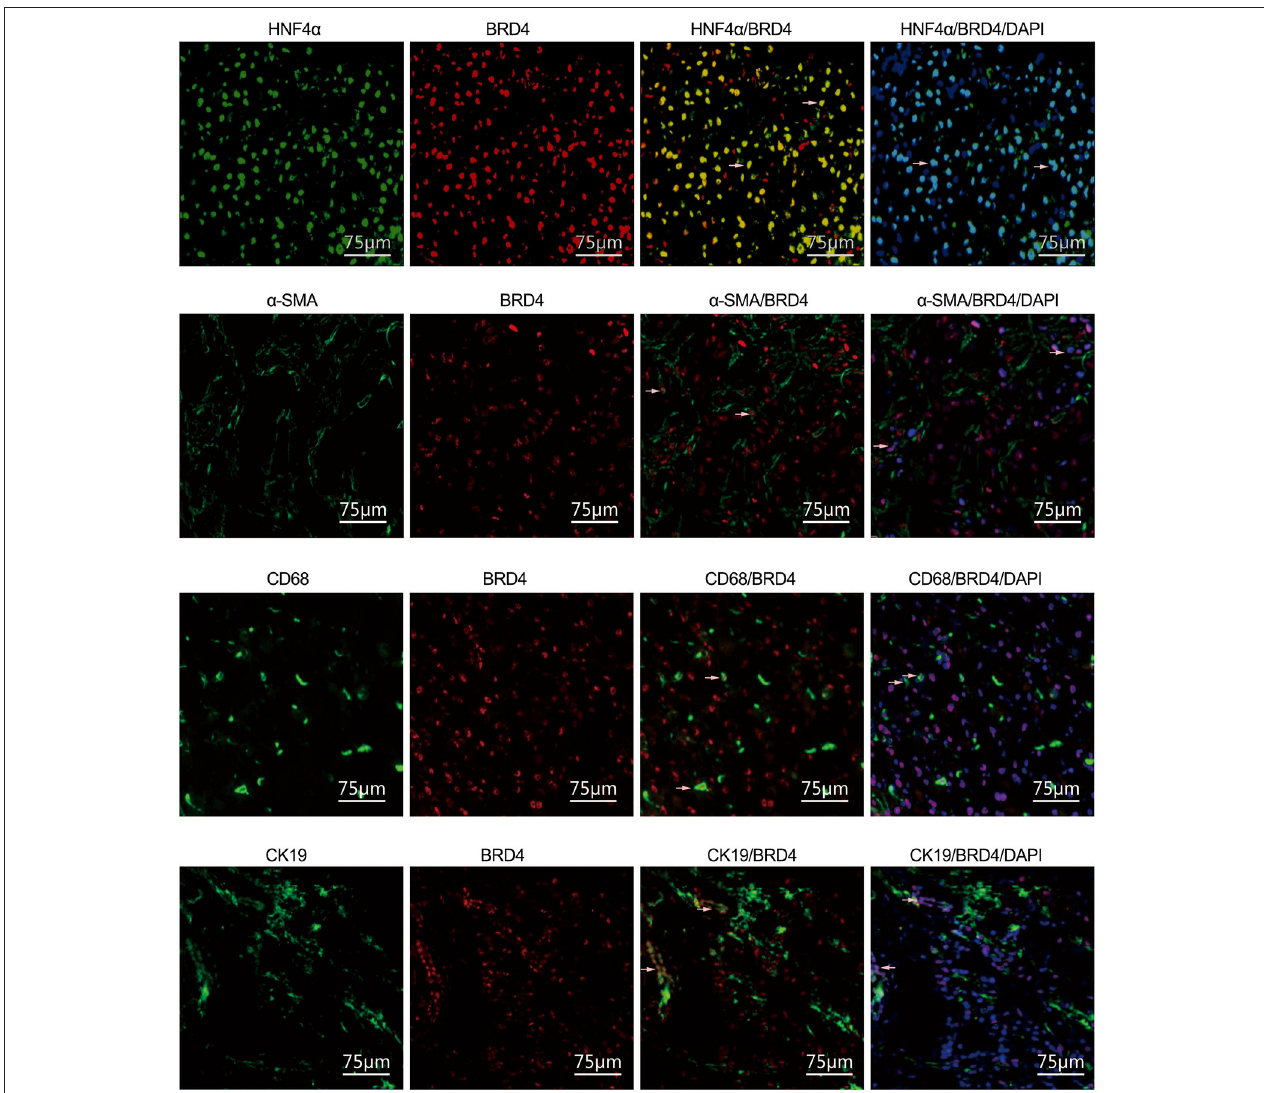
FIGURE 3 | Immunofluorescence analysis of cellular localization of BRD4 in the liver tissues. Immunofluorescence (IF) analysis was conducted to visualize the cellular localization of BRD4 in the liver tissues as described in Materials and Methods. The representative double immunofluorescence images showed expression of HNF4 α (green), α -SMA (green), CD68 (green), CK19 (green), and BRD4 (red) in normal and HBV fibrotic liver tissue. Scale bar: 75 µ m. BRD4, bromodomain-containing protein 4; HNF4 α , hepatocyte nuclear factor 4 alpha; α -SMA, α -smooth muscle actin; CD68, cluster of differentiation 68; CK19, cytokeratin